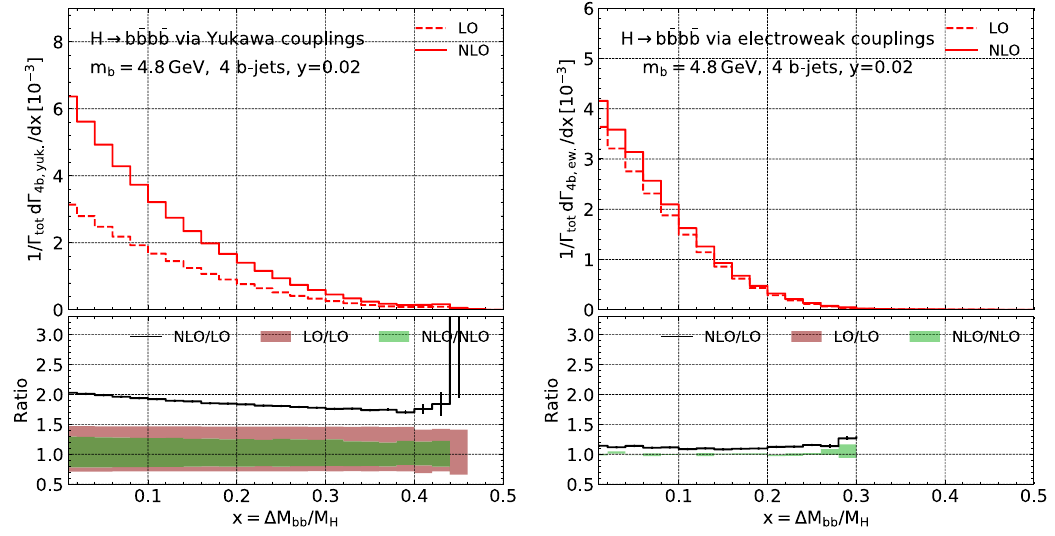
Figure 14 . Similar to figure 7 for distribution as a function of the invariant mass asymmetry of all b -jet pairs.